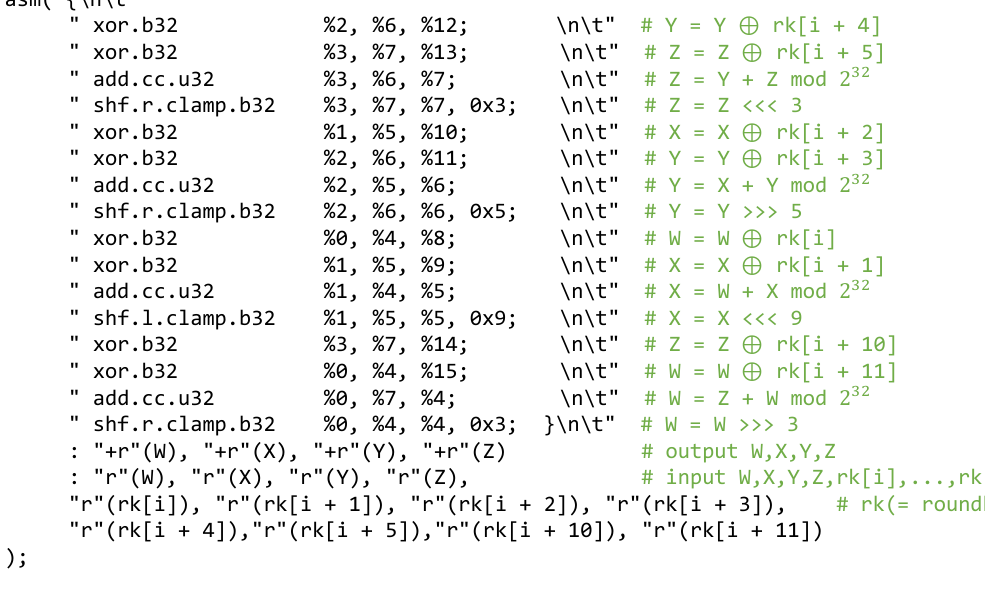
Figure 10. Inline PTX code of LEA round